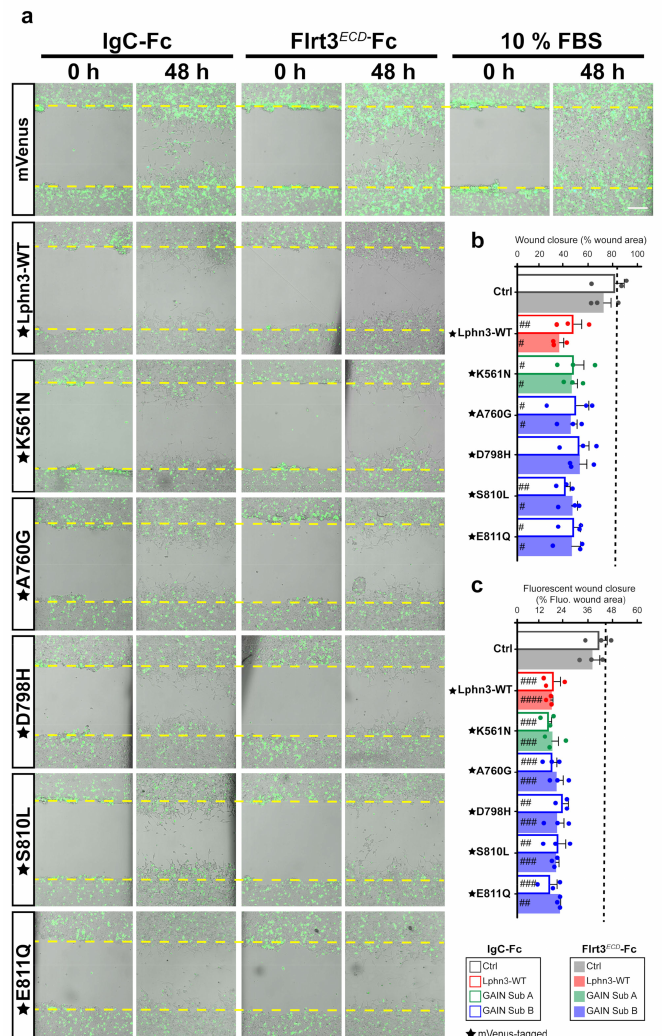
Figure 7. Lphn3-induced delay in cell-autonomous and non-cell-autonomous polarized migration is unperturbed by cancer-related GAIN domain mutations in wound healing assays. ( a ) Representative merged images from bright field and epifluorescence microscopy of mVenus-tagged Lphn3-expressing cells or mVenus control cells depicting wound closure assays captured at the initial scratch into the cell monolayer (zero hours) and at the same scratch area 48 h later, in the absence (IgC-Fc) and presence of receptor ligand Flrt3 ECD -Fc. The yellow dotted lines represent the edges of the scratch at time zero hours. Cells incubated with 10% FBS were used as positive migration controls. Scale bar: 200 µ m. ( b ) Percentage scratch closure data in the presence of IgC-Fc or Flrt3 ECD -Fc represented as the percentage of the total scratch area at zero hours that is occupied by cells at 48h, in bright field images. ( c ) Ratio between fluorescence area occupied by cells expressing mVenus signal in the wound (mVenus-tagged receptors or control cells) and total fluorescence area in the field of view. The dotted line represents the data corresponding to positive control migration values. Subdomain A (GAIN Sub A) and B (GAIN Sub B) of GAIN domain. mVenus-tagged receptor constructs are indicated by a star ( (cid:70) ). Data are represented as the mean values of at least three independent experiments ( n = 3). Statistical analysis was performed using one-way ANOVA. Error bars indicate S.E.M., p values between mVenus-tagged Lphn3 variants and control data are indicated by # inside histograms: #### p ≤ 0.0001, ### p ≤ 0.001, ## p ≤ 0.01, # p ≤